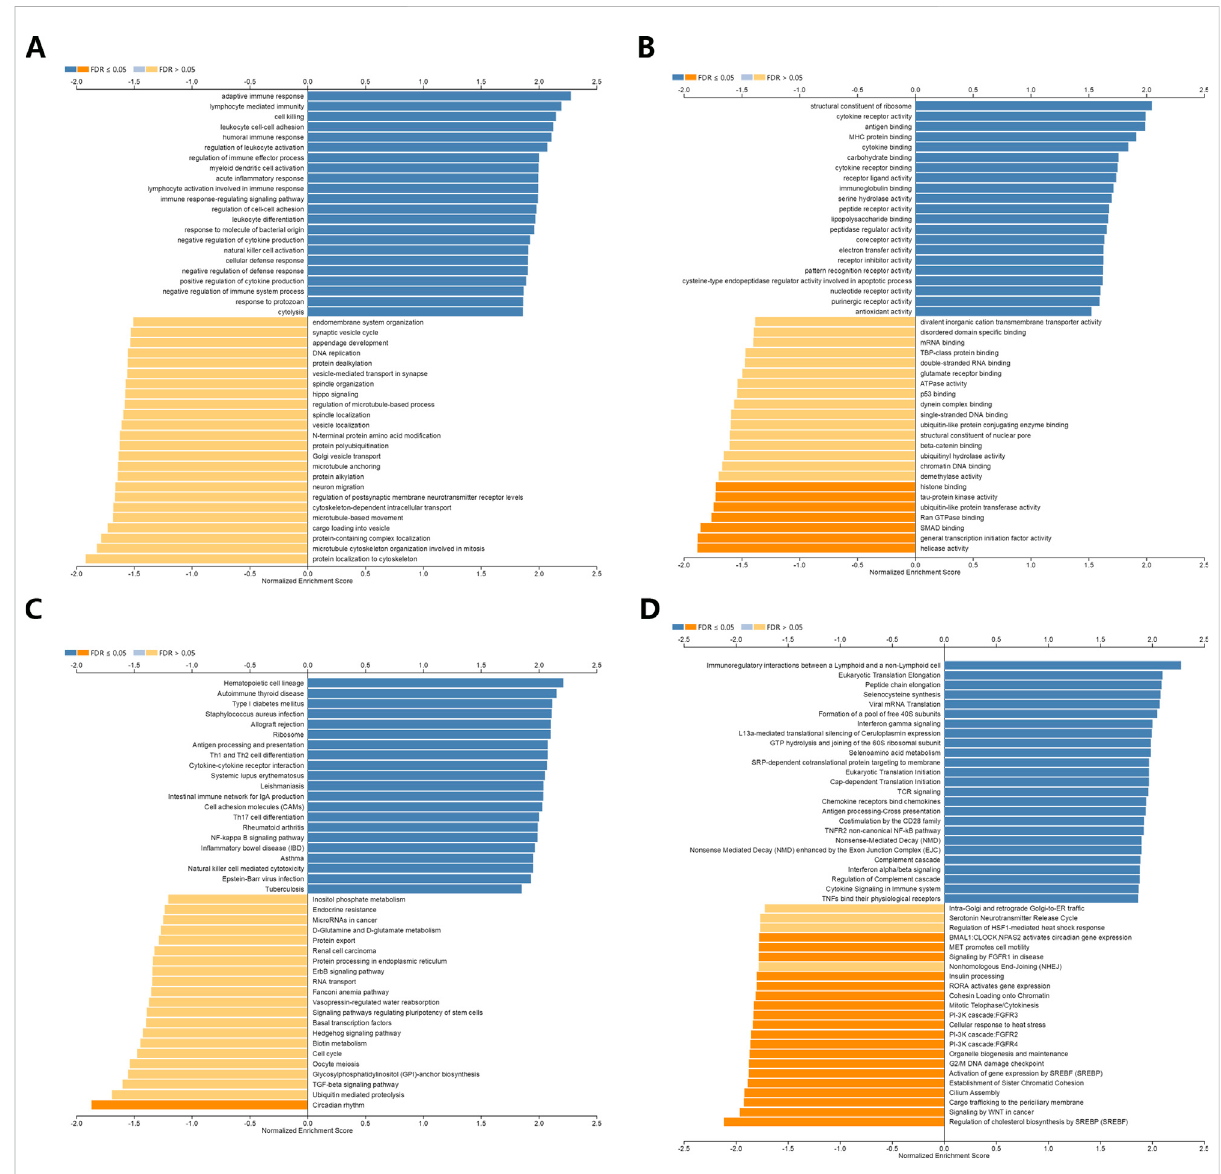
FIGURE 3 Function and pathway enrichment analyses of NR1H3 in breast cancer. (A,B) Signi fi cant Gene Ontology terms of NR1H3, including biological processes(BP)andmolecularfunction(MF). (C,D) Signi fi cantGSEAresultsofNR1H3,includingKEGGpathwaysandReactomepathways.GSEA,Gene Set Enrichment Analysis; KEGG, Kyoto Encyclopedia of Genes and